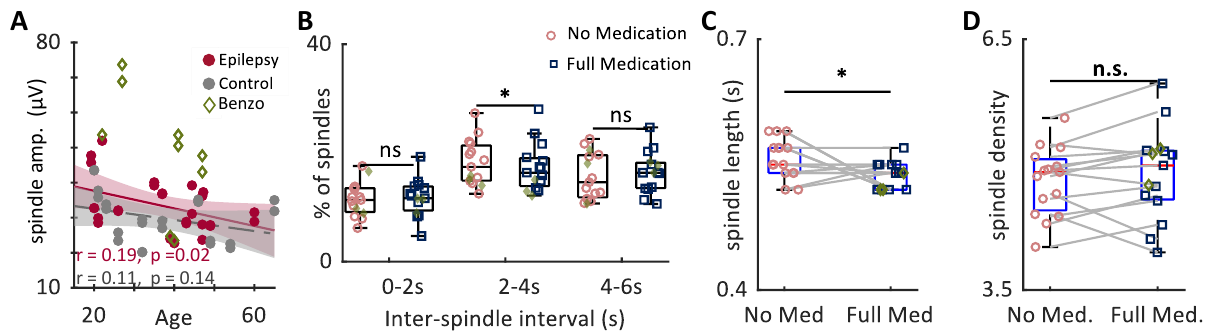
Figure 3. Spindle amplitude is higher in patients with epilepsy and spindle length and the amount of 2–4 s inter-spindle intervals are reduced with anti-seizure medications. ( A ) Linear regression of spindle amplitude controlling for age and benzodiazepine use. The Epilepsy group (red) shows significantly higher amplitudes across ages (ANCOVA, F (1, 49) = 4.06; p = 0.049, excluding benzodiazepine users (green diamonds). ( B ) The time between spindles were reduced with ASM at the individual level and were specific to a reduction in spindles with a 2 – 4 s inter-spindle interval ( p = 0.017). Changes in inter-spindle interval were not driven by benzodiazepine treatment, as benzodiazepine users did not differ from non-users (unpaired t -test, p = 0.32, green diamonds). ( C ) Individuals show a small but significant reduction in modal spindle length with medication (paired t -test, p = 0.039). ( D ) Spindle densities did not differ with medication ( p = 0.28, paired t -test). * p < 0.05, n.s. p > 0.05.